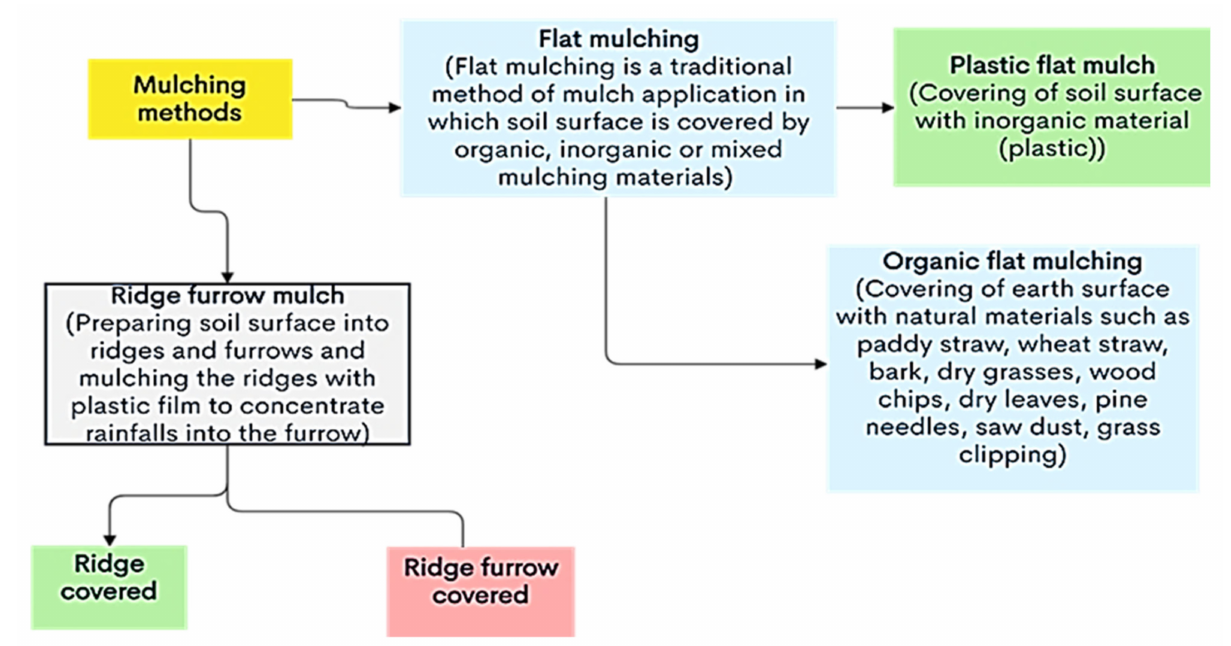
Figure 6. An illustration of the various mulching techniques.